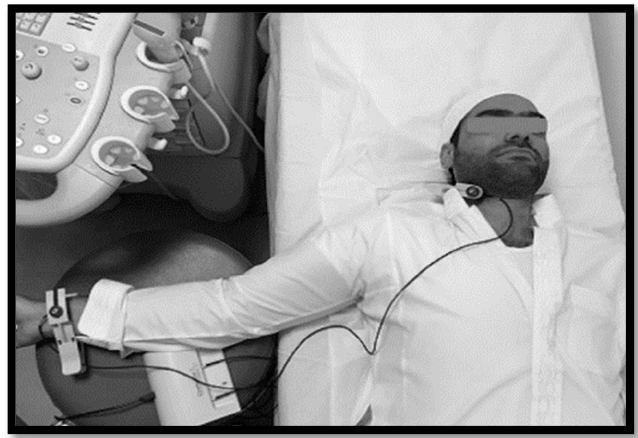
Figure 2. The pulse wave analysis test being performed on a participant.